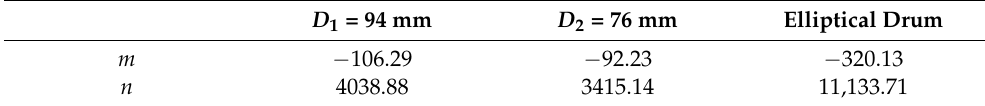
Table 2. Trends of the number of contacts with 1 rad/s 2 rotational